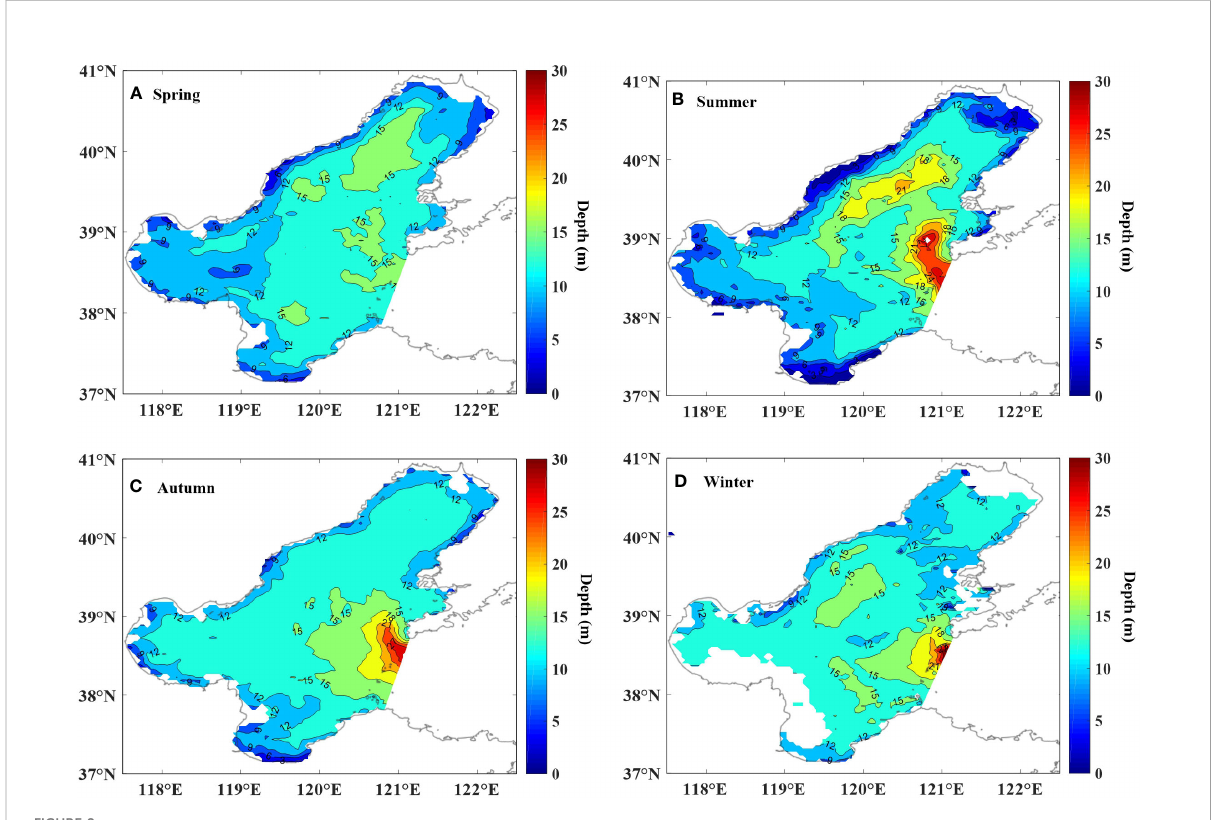
FIGURE 8 The depth of Z eu distribution in spring (A) , summer (B) , autumn (C) and winter (D)